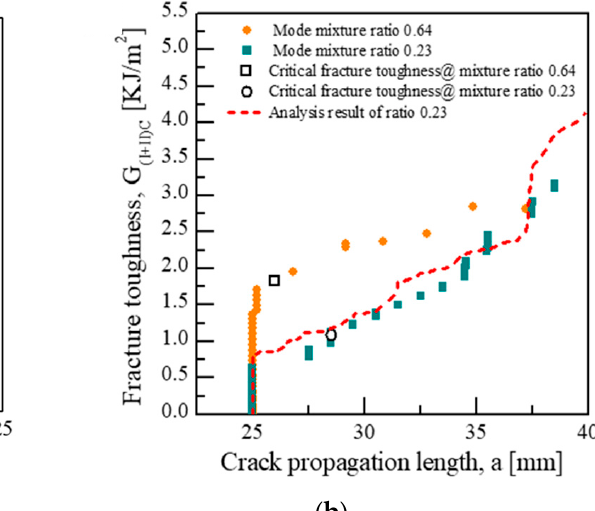
( b ) Figure 15. FE analysis result shape of Mode II: ( a ) in-plane stress contour and ( b ) crack growth length at applied displacement.